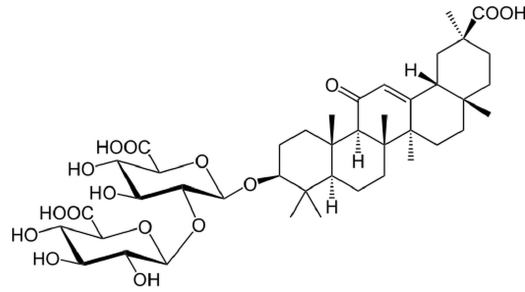
Fig. 5: Chemical structure of